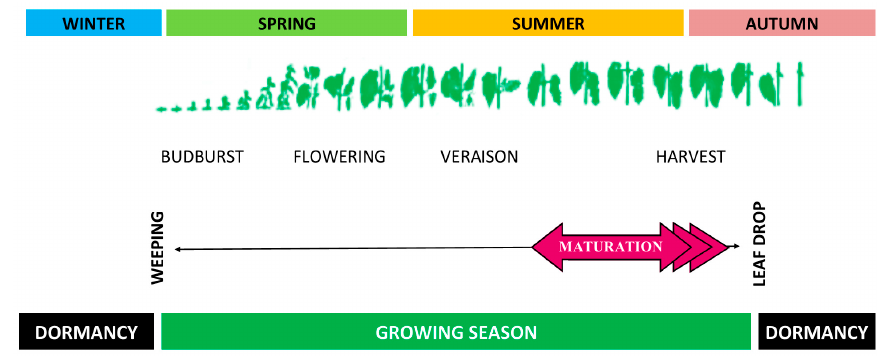
Figure 2. Vegetative cycle and main vine phenological stages.